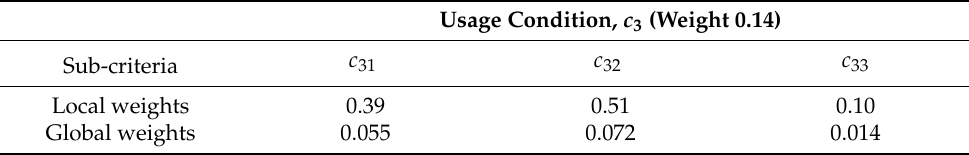
Table 10. Weights of sub-criteria related to the usage